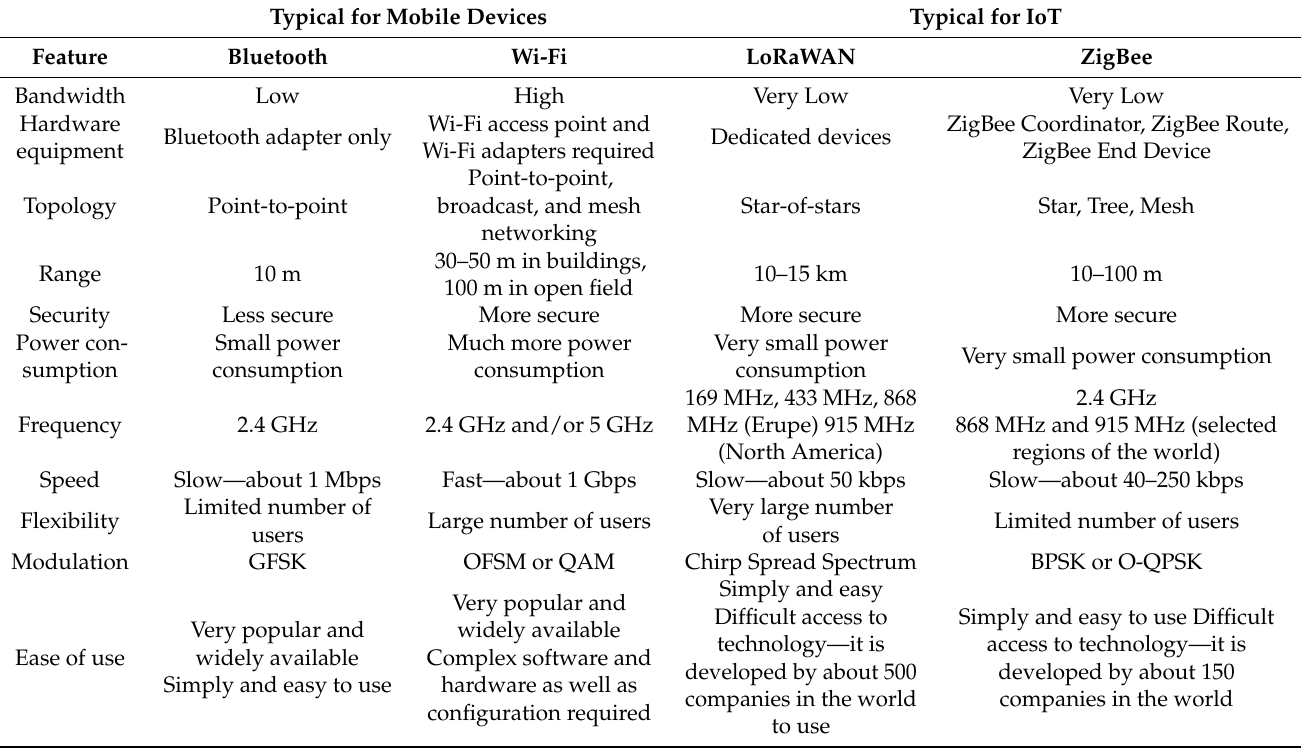
Table 2. Summary of selected parameters and features of the Wi-Fi and Bluetooth